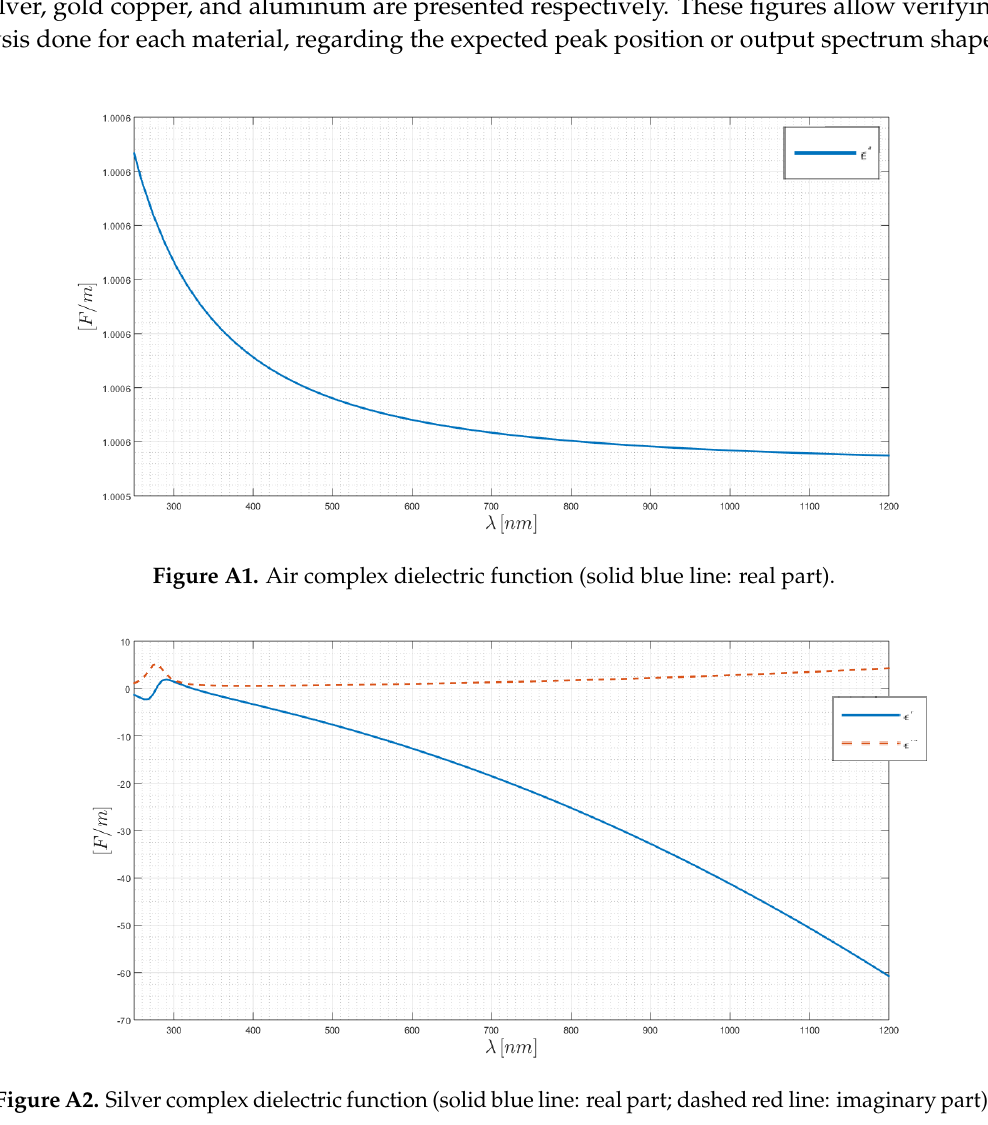
Figure A2. Silver complex dielectric function (solid blue line: real part; dashed red line: imaginary part).